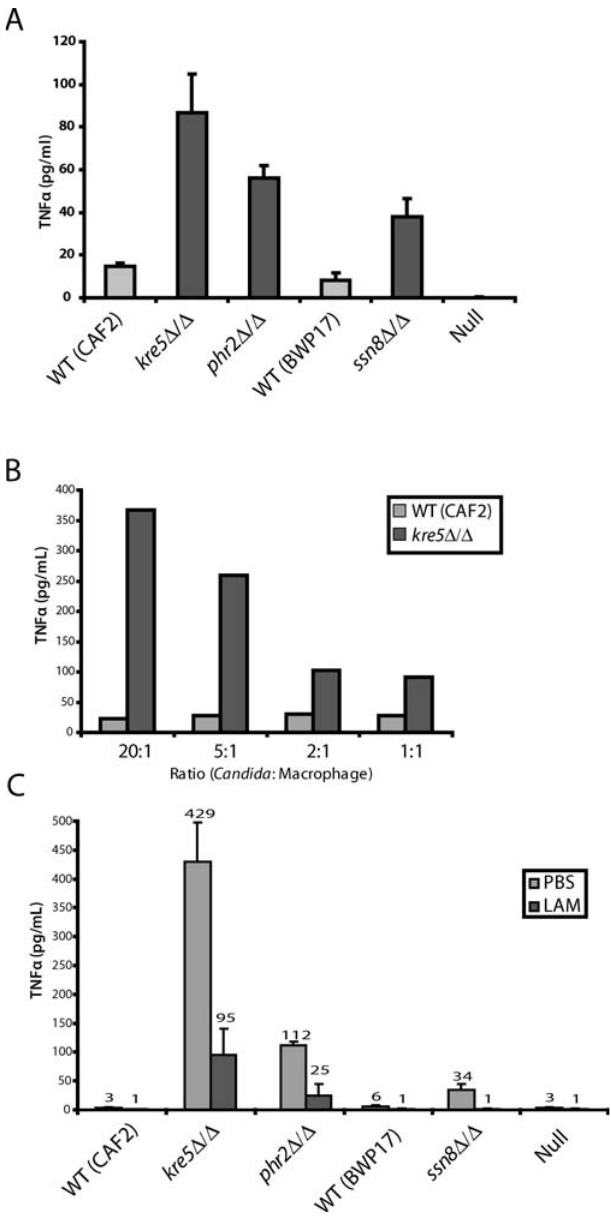
Figure 6. Unmasked C. albicans Mutants Hyperelicit TNF a from Macrophages through the b -Glucan Receptor (A) C. albicans strains were exposed to RAW264.7 macrophages at a ratio of 2:1 (yeast:macrophage), and supernatants were collected after 6 h. (B) Different numbers of C. albicans (wild-type or kre5 D / D mutant) were exposed to BMDMs, and supernatants were collected after 6 h. (C) BMDMs were pretreated for 20 min on ice with media or soluble b - glucan (laminarin); they were then exposed to different C. albicans strains at a ratio of 10:1 (yeast:macrophage). After unbound fungi were washed off, macrophages were incubated for 6 h at 37 8 C, and supernatants were collected for TNF a quantitation. DOI: